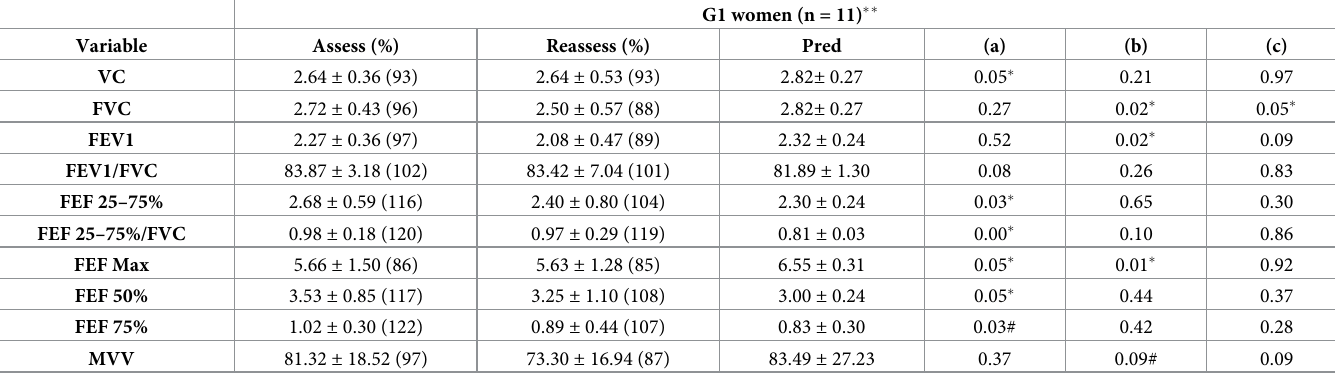
Table 3. Comparison of pulmonary lung function of G1 individuals without lung injury (n = 12) at chest CT (2014–2019).